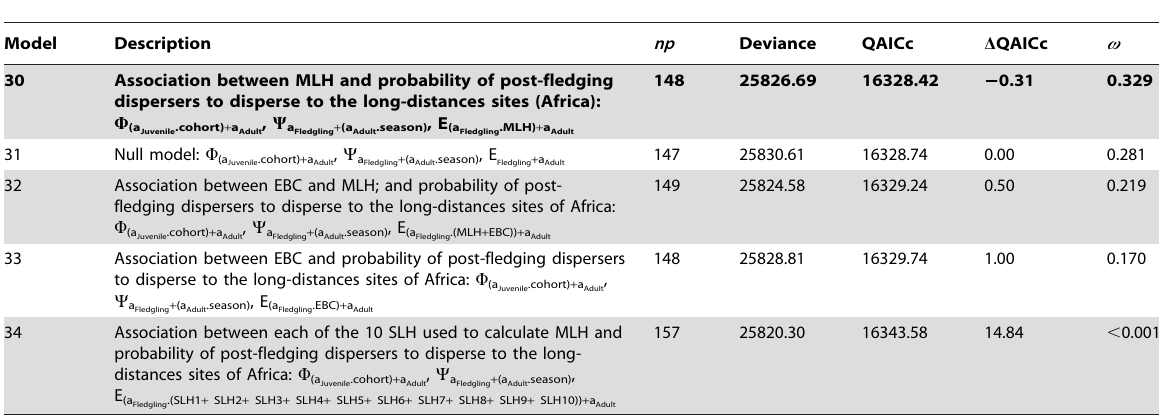
Table 3. Model selection for models evaluating an association between the life history trait of propensity of post-fledging dispersers to disperse long-distances (the intermediate-distance sites of Italy and Iberian Peninsula or the long-distance sites of Africa) and the individual covariates of microsatellite multilocus heterozygosity (MLH) and early body condition (EBC).